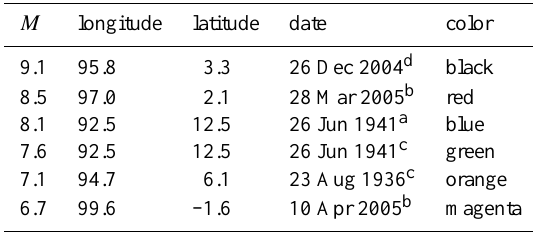
Table 2. Historical tsunami events in the Indian Ocean taken from a Murty and Rafiq (1991), b ITIC (2005), c National Geophysical Data Center (2009), and d Kanamori (2006). The events in rows 3 and 4 are the same but modeled with different magnitudes found in the literature. Colors correspond to those in Figs. 4 and